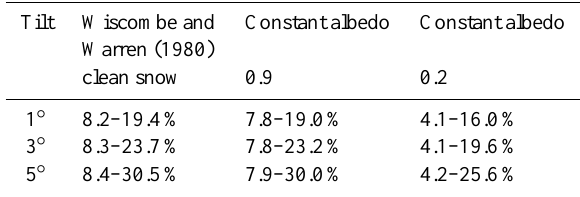
Table 3. Diffuse proportion ( P dif ) for different surface albedos. The results are for the global (250 to 4500nm), spectral range. Variabil- ity within the ranges presented is a function of sensor pointing az- imuth as well as solar zenith